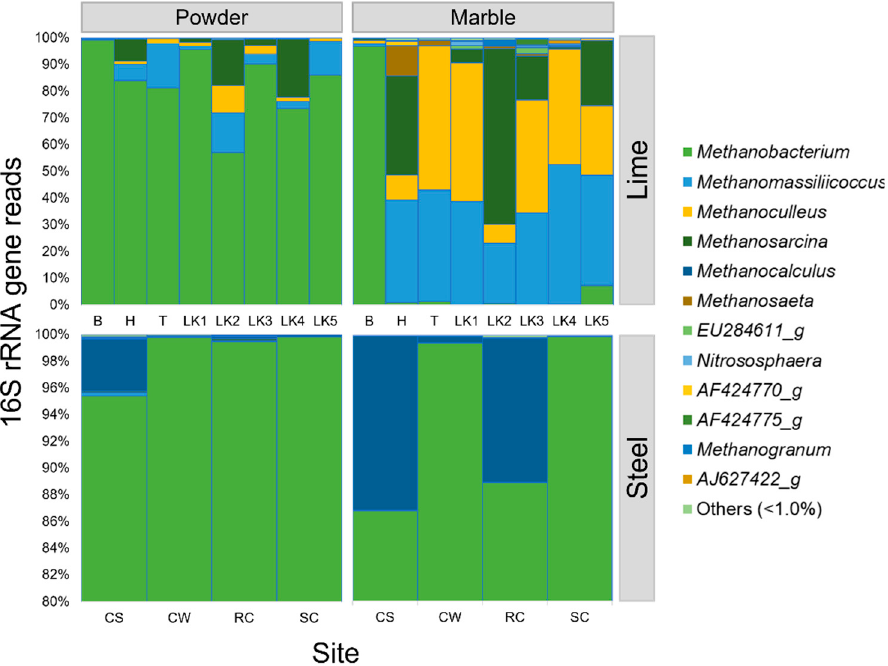
Figure 4. Community profiles of the microcosms that had been amended with either calcium carbonate powder or marble chips and supplemented with a lime site hydrogenotrophic methanogen enrichment or from a steel slag waste site.